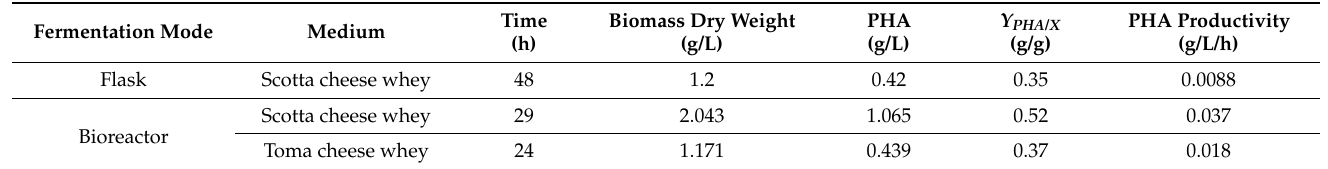
Table 1. Main parameters of PHA production in flask and bioreactor tests with scotta and Toma cheese whey. The relative standard error of the data reported is 5% (calculated from three replicates).